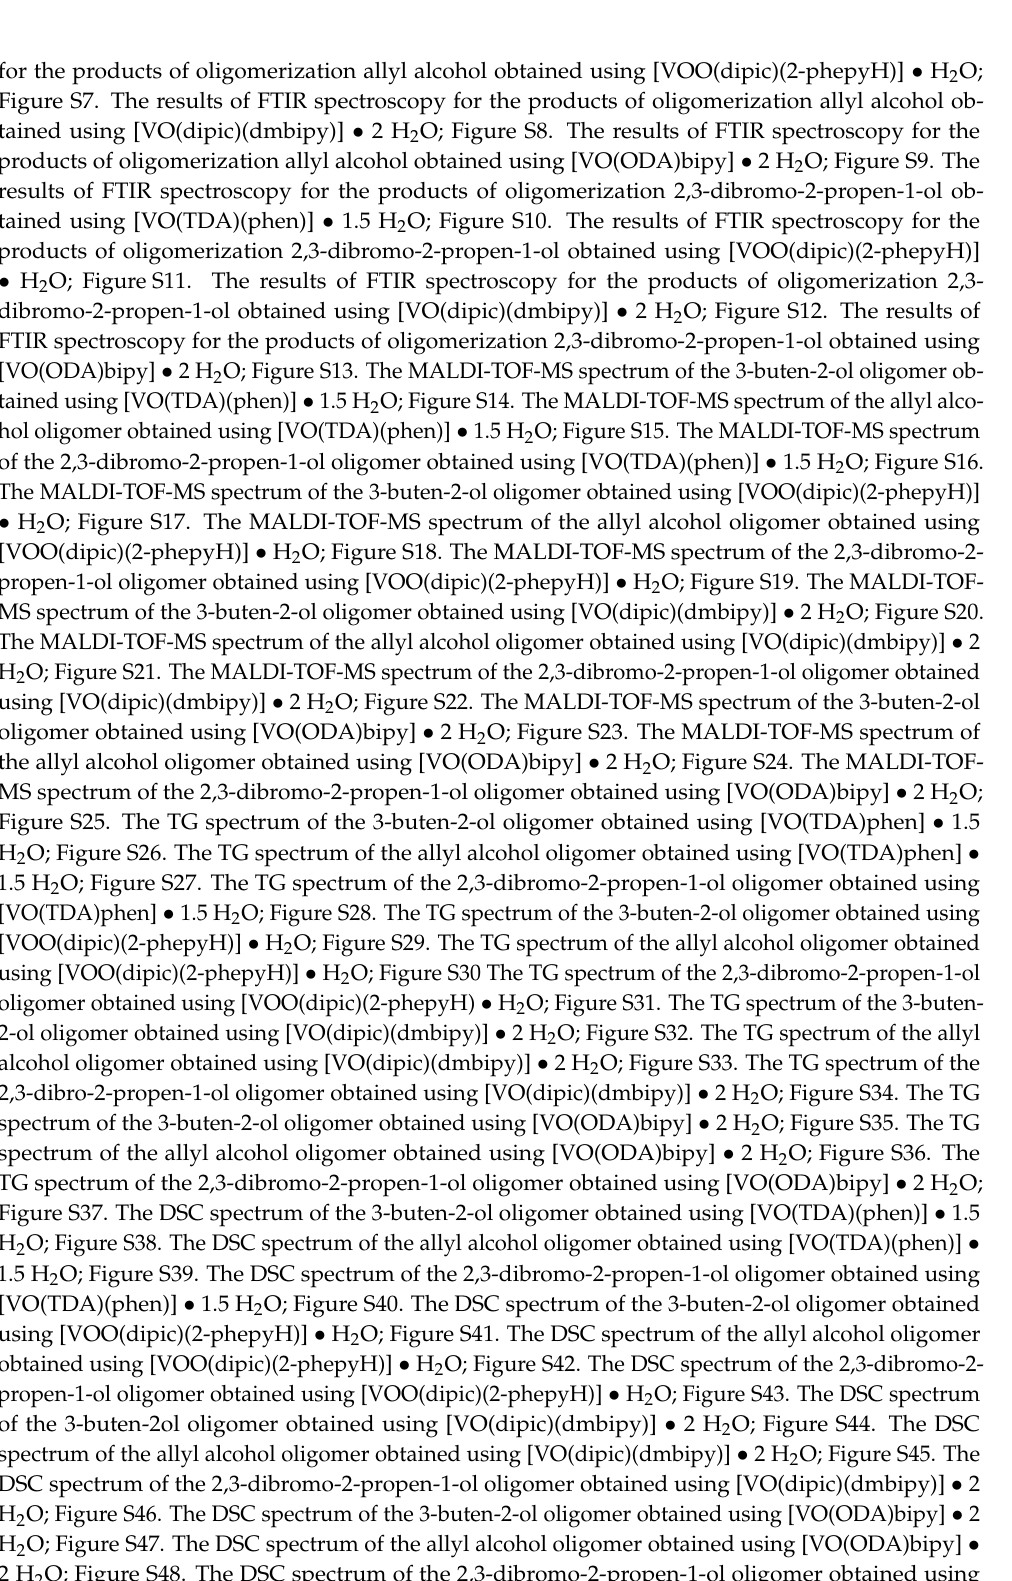
H 2 O; Figure S46. The DSC spectrum of the 3-buten-2-ol oligomer obtained using [VO(ODA)bipy] • 2 H 2 O; Figure S47. The DSC spectrum of the allyl alcohol oligomer obtained using [VO(ODA)bipy] • 2 H 2 O; Figure S48. The DSC spectrum of the 2,3-dibromo-2-propen-1-ol oligomer obtained